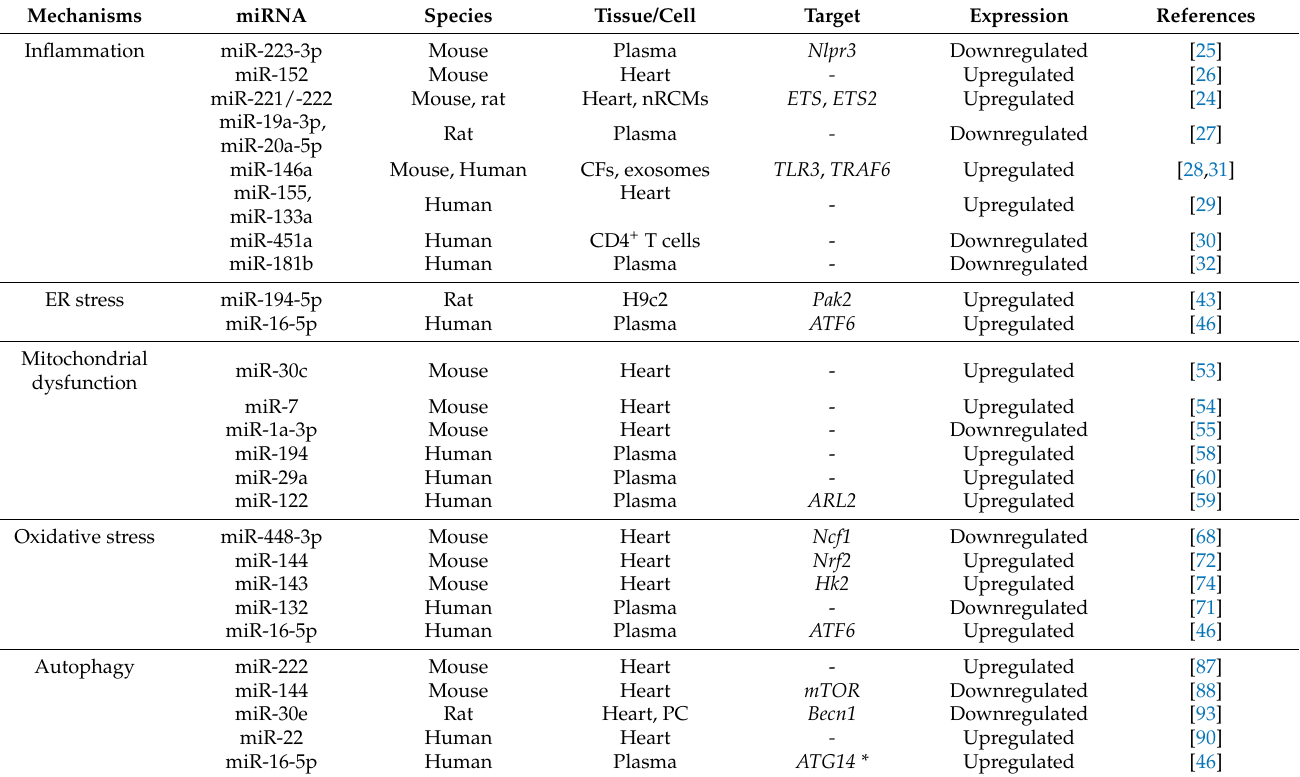
Table 1. Summary of reported miRNAs in the distinct mechanisms involved in DCM progression. miRNA: microRNA; nRCMs, neonatal rat cardiomyocytes; CFs, cardiac fibroblasts; PC, primary cardiomyocyte. Note: Asterisk means not experimentally